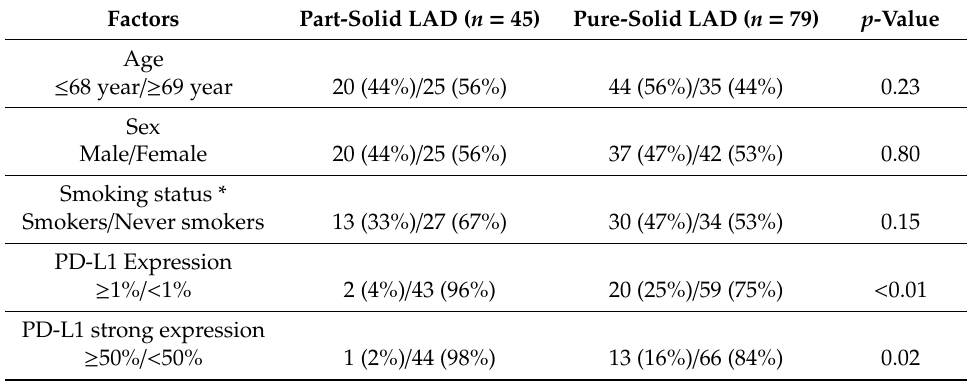
Table 1. Characteristics of patients with part-solid or pure-solid lung adenocarcinomas (LAD).